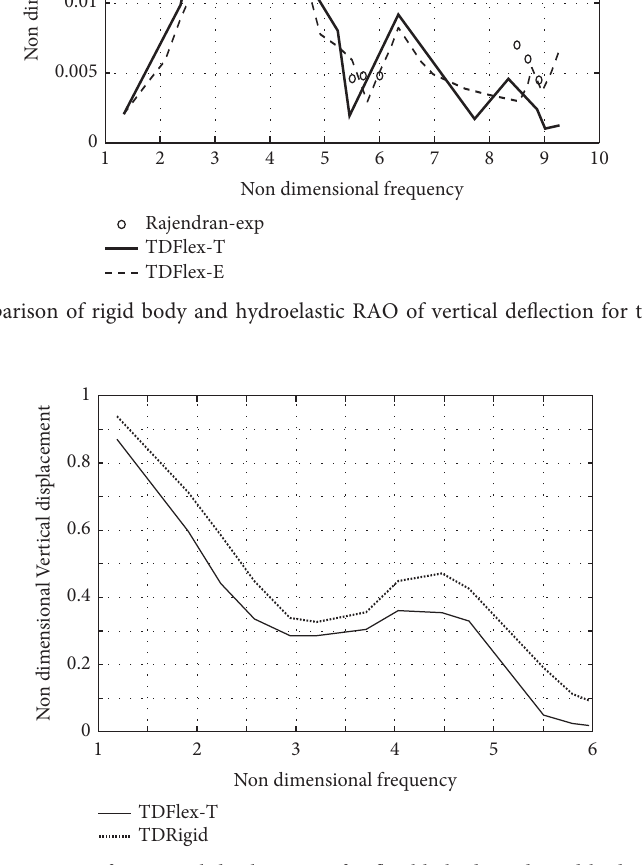
Figure 10: RAOs for vertical displacement for flexible body and rigid body, ULC.